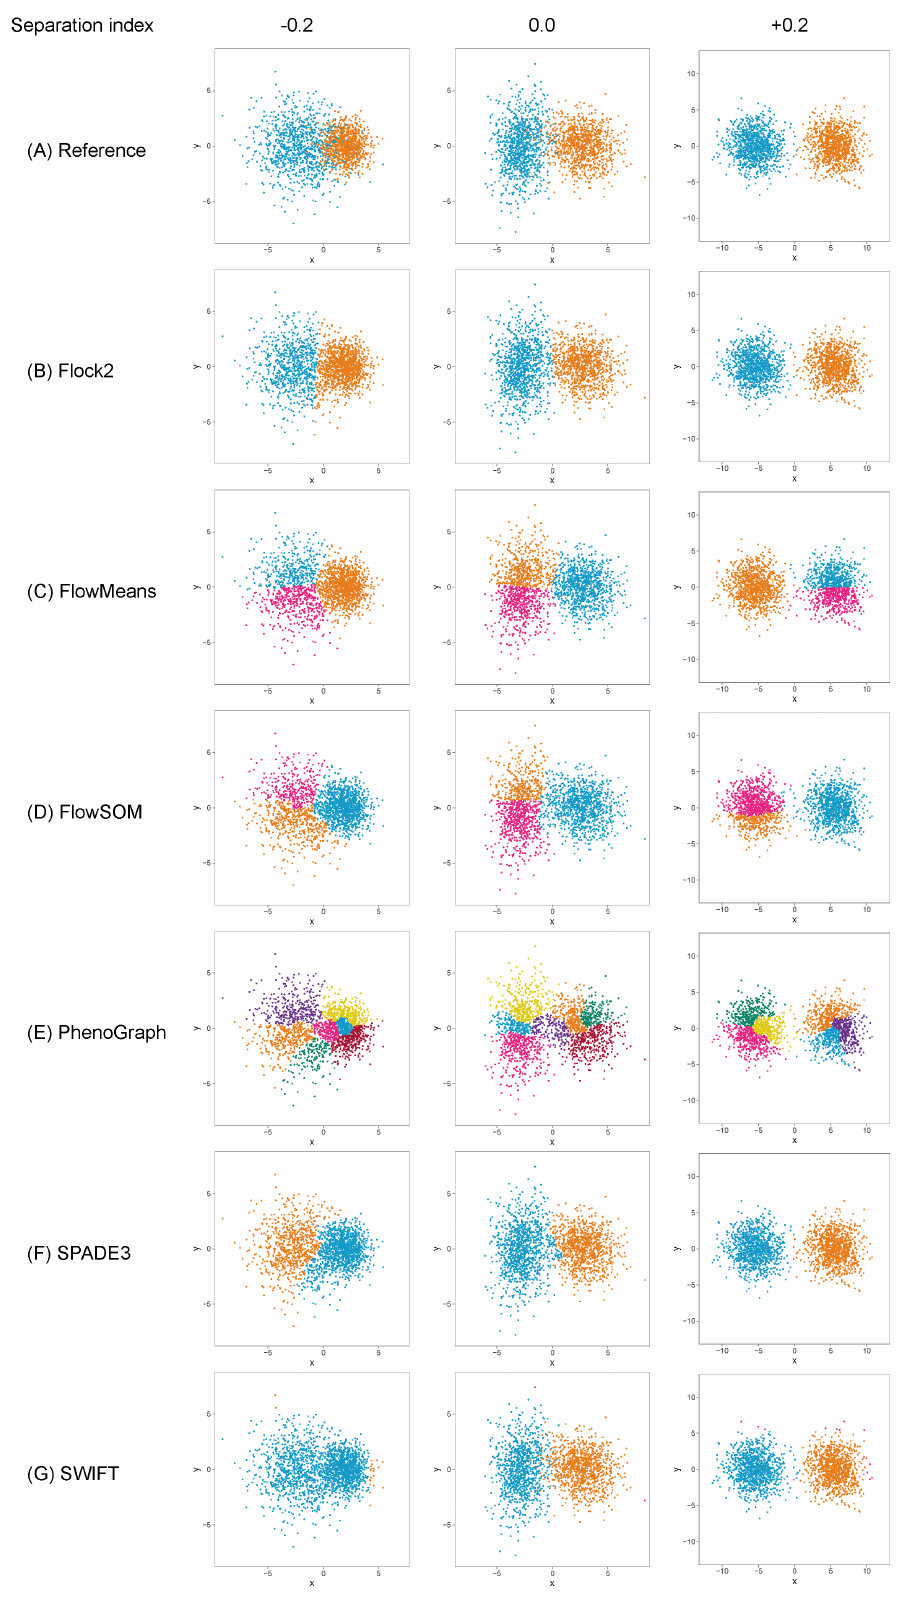
Figure 2. Clustering examplesfrom different software on a two-cluster synthetic flow cytometry dataset with different degrees of separation between